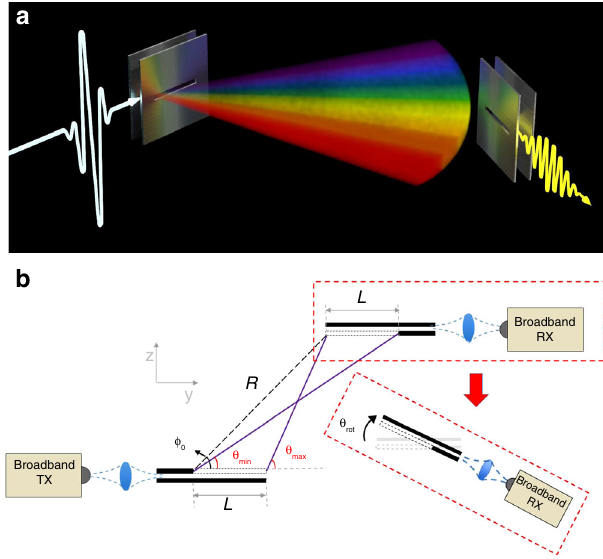
Fig. 1 Drawings of the experimental arrangement. a An illustration showing the “ THz rainbow ” emitted by a leaky waveguide (LWG) after excitation of the waveguide with a broadband input signal. A receiver (RX), also employing a LWG, captures a portion of this broadband signal. The range of the received spectrum can be used to determine, not only the angle at which the receiver is located, but also the rotation of the receiver relative to the transmitter. When a broadband transmitter (TX) is used, the client ’ s position can be obtained in a single shot. b A schematic of the experiment, in a plan view, de fi ning various parameters used in the discussion, and illustrating the rotation of the RX